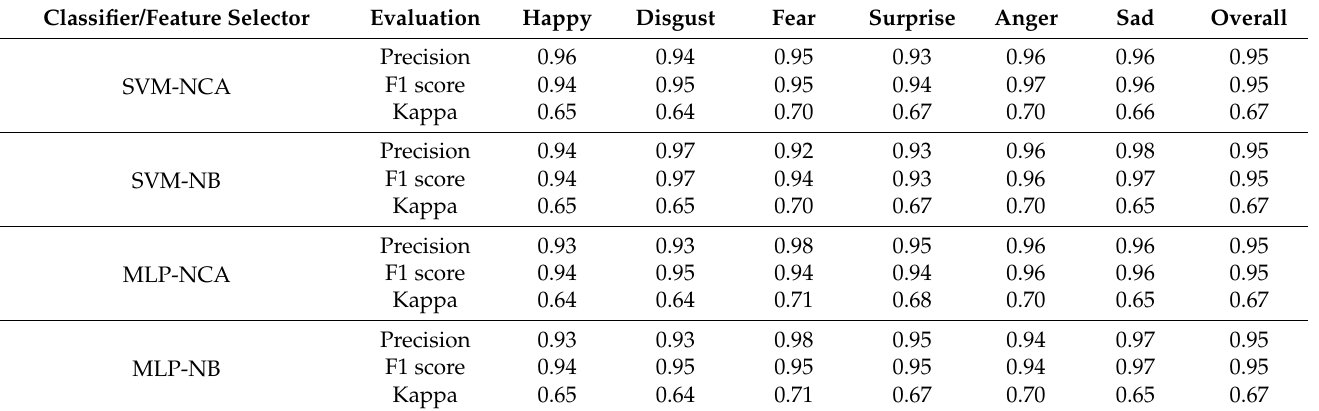
Table 4. Precision, F1 score, and Kappa statistical evaluation method reported from classification human affective state recognition based on 27 sub-ROIs and SVM and MLP classifiers with NCA and NB feature selection algorithms.